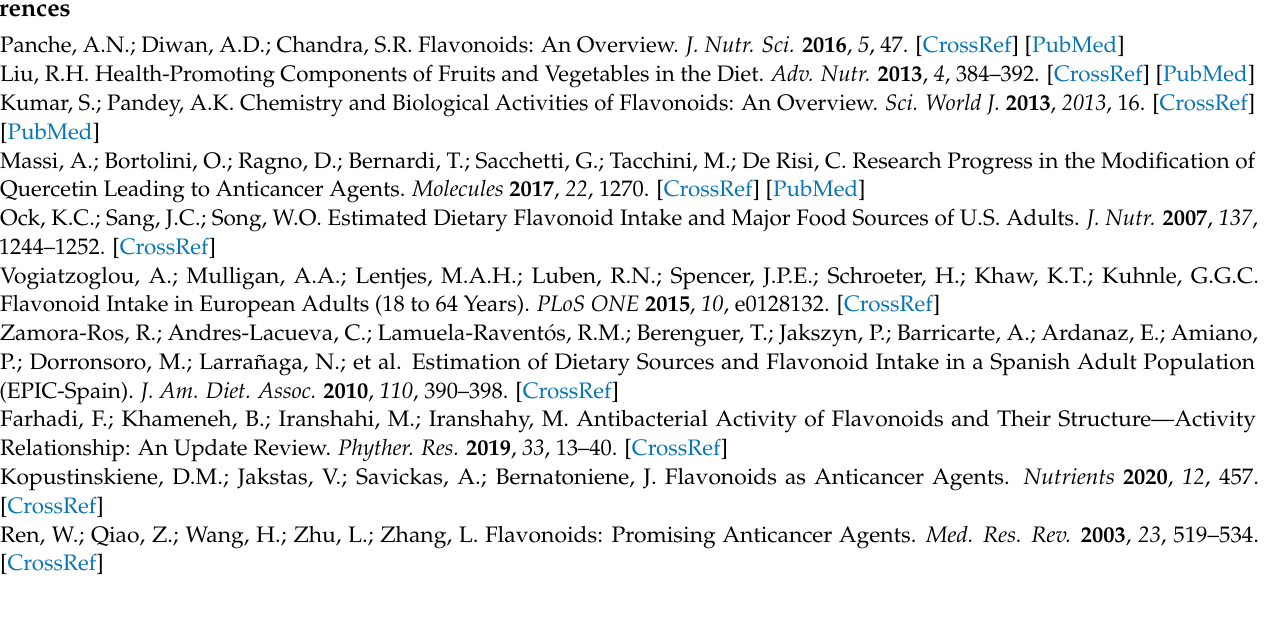
DMSO-d 6 ): compound 2 ; Figure S2: 1 H NMR spectrum (500 MHz, DMSO-d 6 ): compound 9 ; Figure S3: 1 H NMR spectrum (500 MHz, DMSO-d 6 ): compound 13 ; Figure S4: 1 H NMR spectrum (500 MHz, DMSO-d 6 ): compound 3 ; Figure S5: 1 H NMR spectrum (500 MHz, DMSO-d 6 ): compound 10 ; Figure S6: 1 H NMR spectrum (500 MHz, DMSO-d 6 ): compound 14 ; Figure S7: 1 H NMR spectrum (500 MHz, DMSO-d 6 ): compound 4 ; Figure S8: 1 H NMR spectrum (500 MHz, DMSO-d 6 ): compound 11 ; Figure S9: 1 H NMR spectrum (500 MHz, DMSO-d 6 ): compound 15 ; Figure S10: 1 H NMR spectrum (500 MHz, DMSO-d 6 ): compound 5 ; Figure S11: 1 H NMR spectrum (500 MHz, DMSO-d 6 ): compound 6 ; Figure S12: 1 H NMR spectrum (500 MHz, DMSO-d 6 ): compound 7 ; S13: HPLC chromatogram of compound 5 ; S14: HPLC chromatogram of compound 11 ; S15: HPLC chromatogram of compound 15 ; S16: HPLC chromatogram of compound 7 ; Figure S17: Mass spectrum of compound 4 ; Figure S18: Mass spectrum of compound 11 ; Figure S19: Mass spectrum of compound 15 ; Figure S20: Mass spectrum of compound 5 ; Figure S21: Mass spectrum of compound 7 and Figure S22: Structure of compounds 1S0–5S0 &